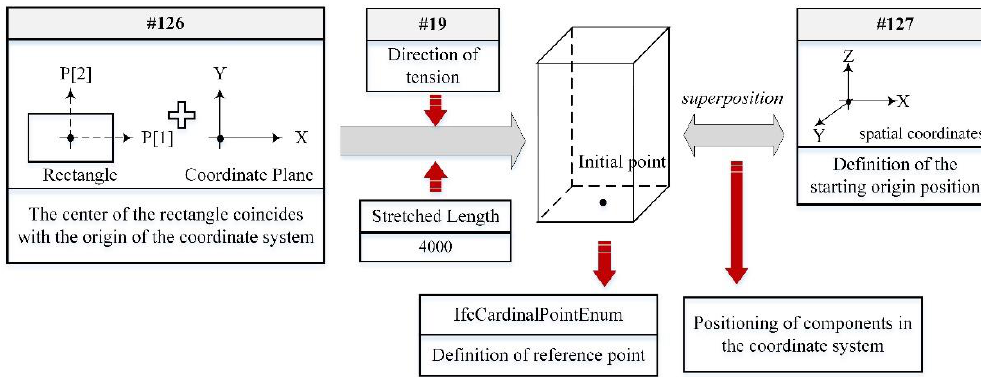
Figure 8. Attributes of IfcExtrudedAreaSolid .